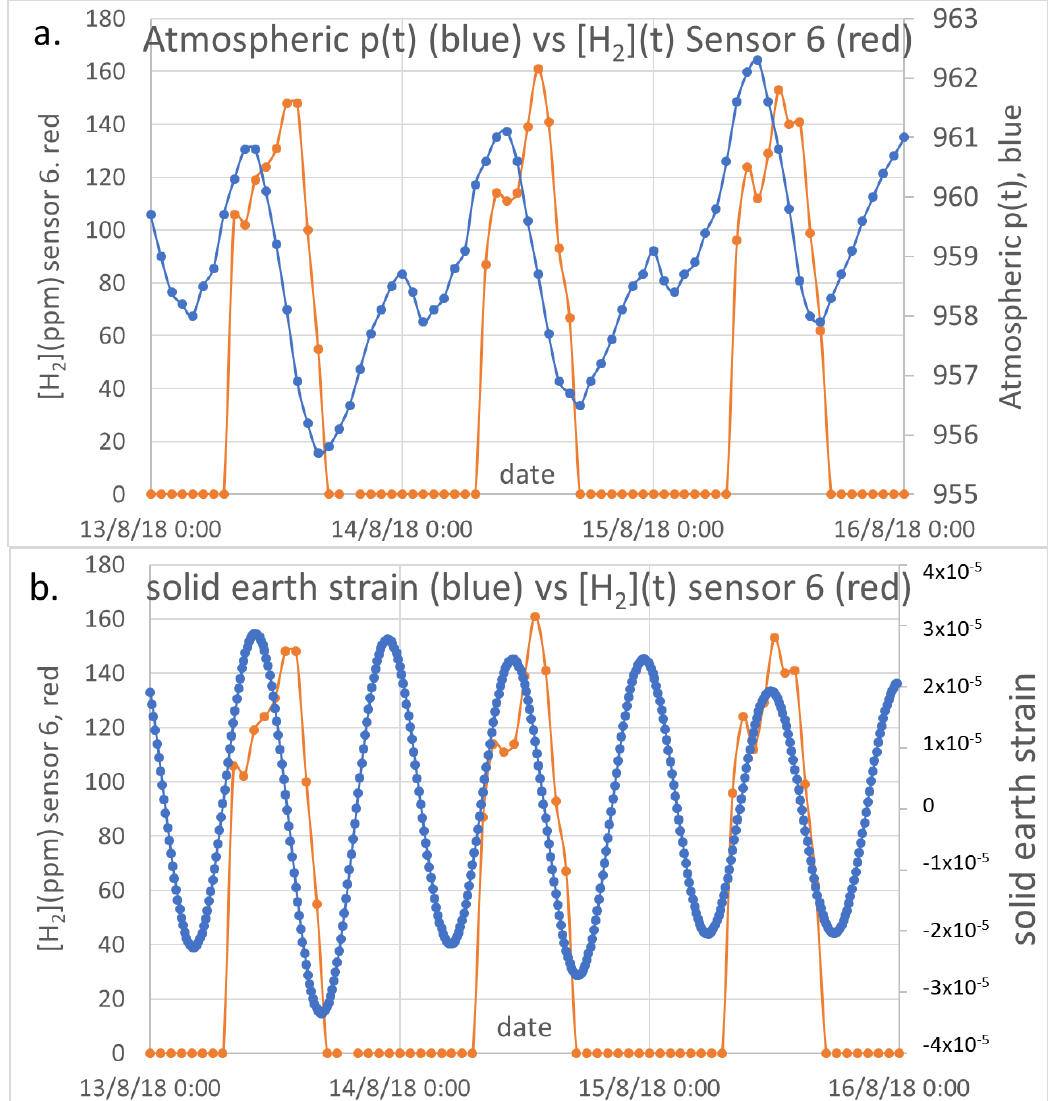
Figure 1. ( a ) Comparison of changes in atmospheric pressure to observe changes in H 2 concentration at 80 cm depth at the location studied by Cathles and Prinzhofer [4] from the 13th to the 16th of August 2018. ( b ) Comparison of changes in solid earth tidal strain at the same site over the same period.